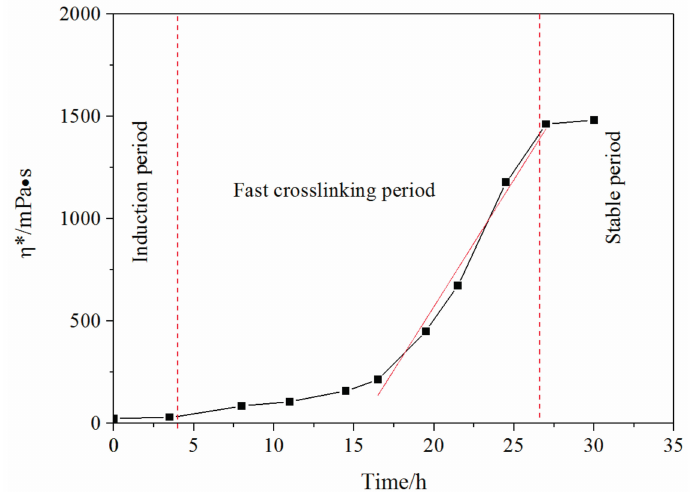
Figure 3. Crosslinking reaction process of the polymer gel.